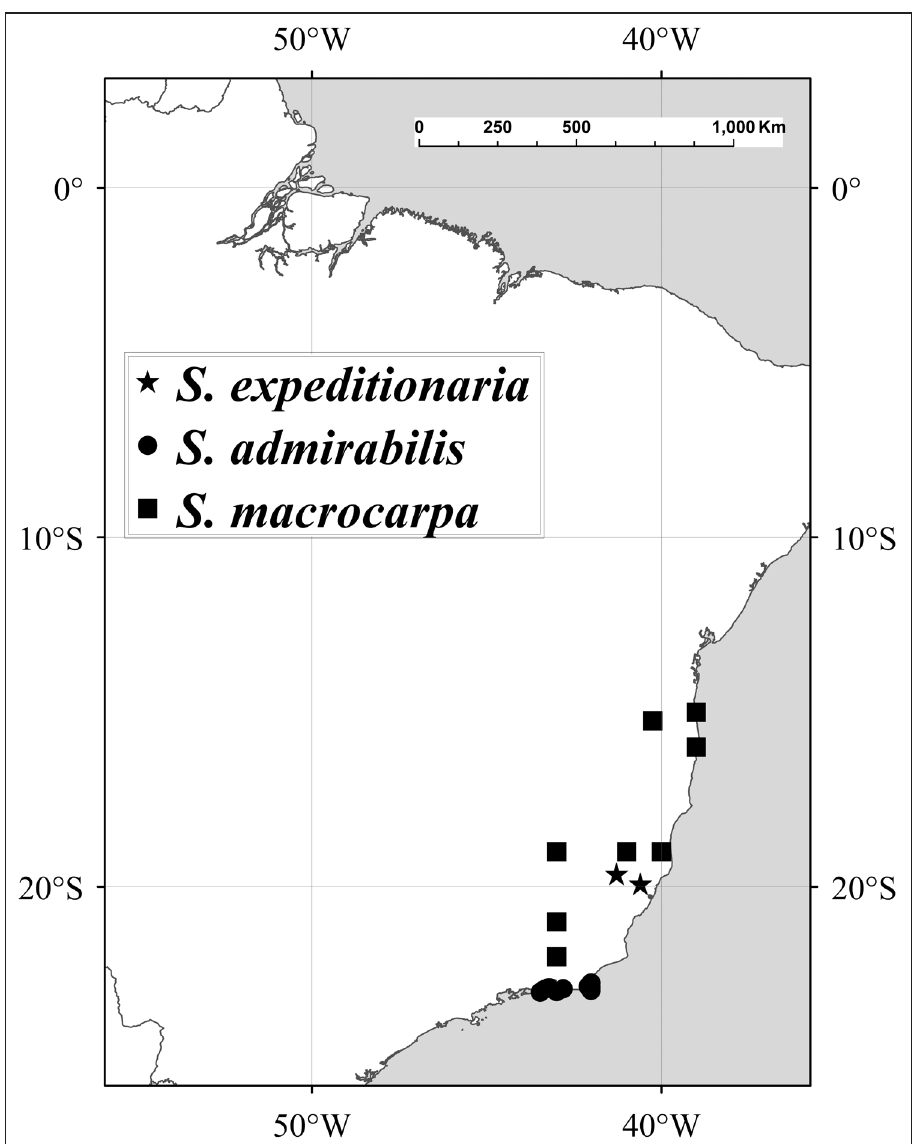
Figure 19. Distributions of Spondias admirabilis , S. expeditionaria , and S.